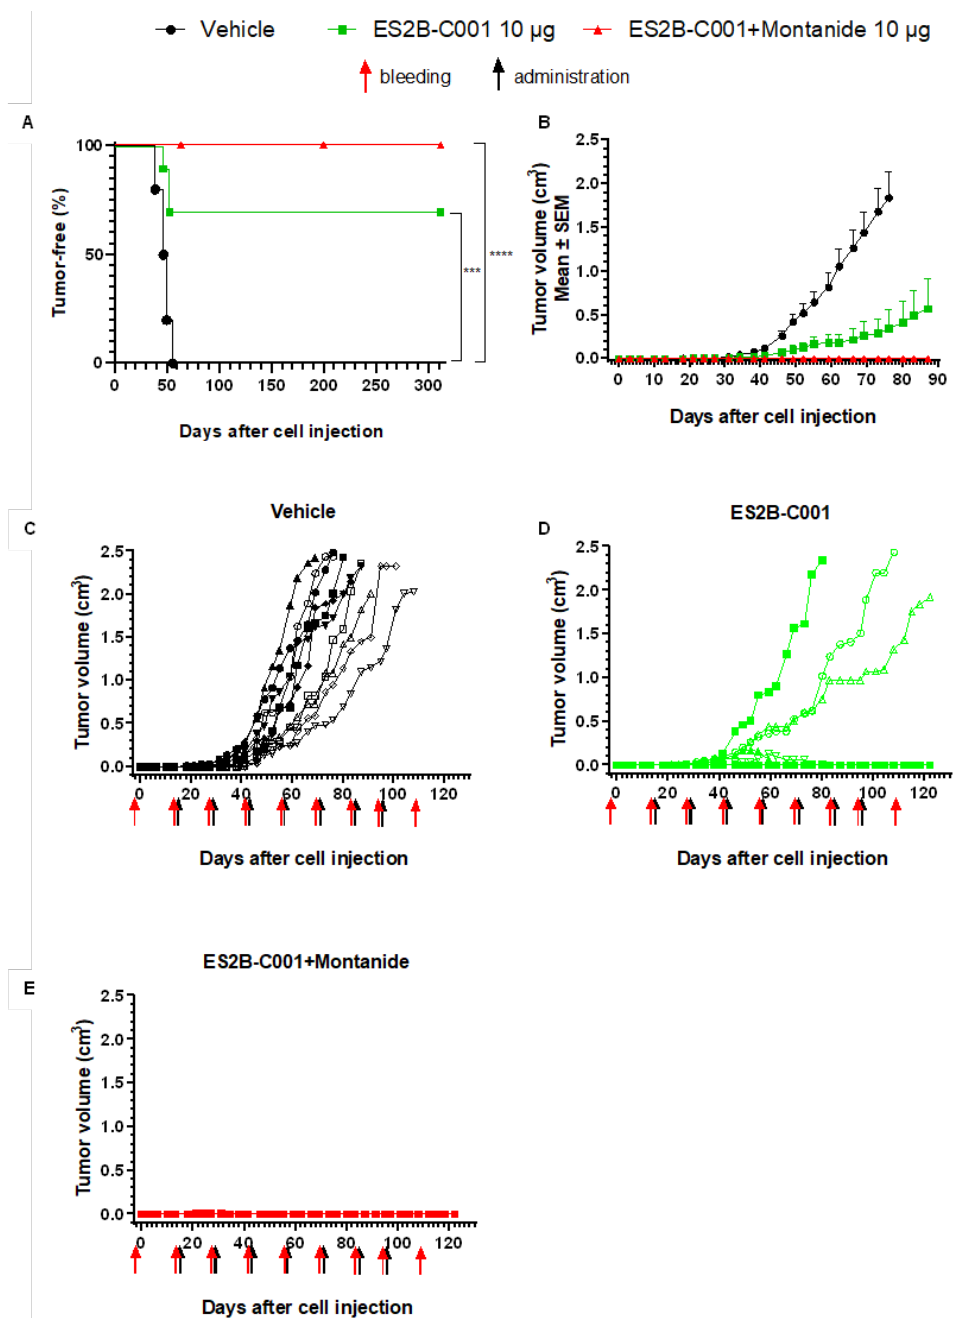
Figure 1. ES2B-C001 therapeutic vaccinations inhibited tumor growth in FVB mice challenged in the